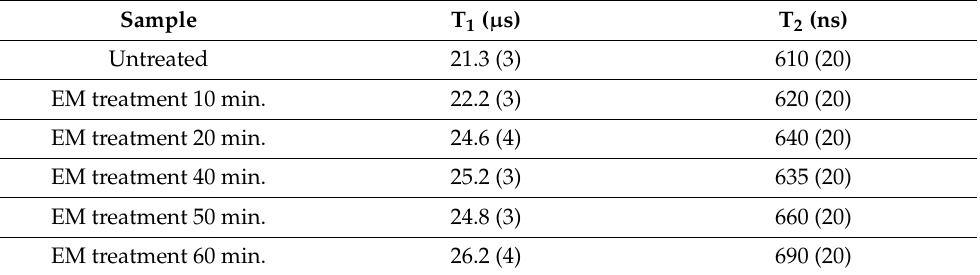
Table 1. Electronic relaxation times for the test samples.